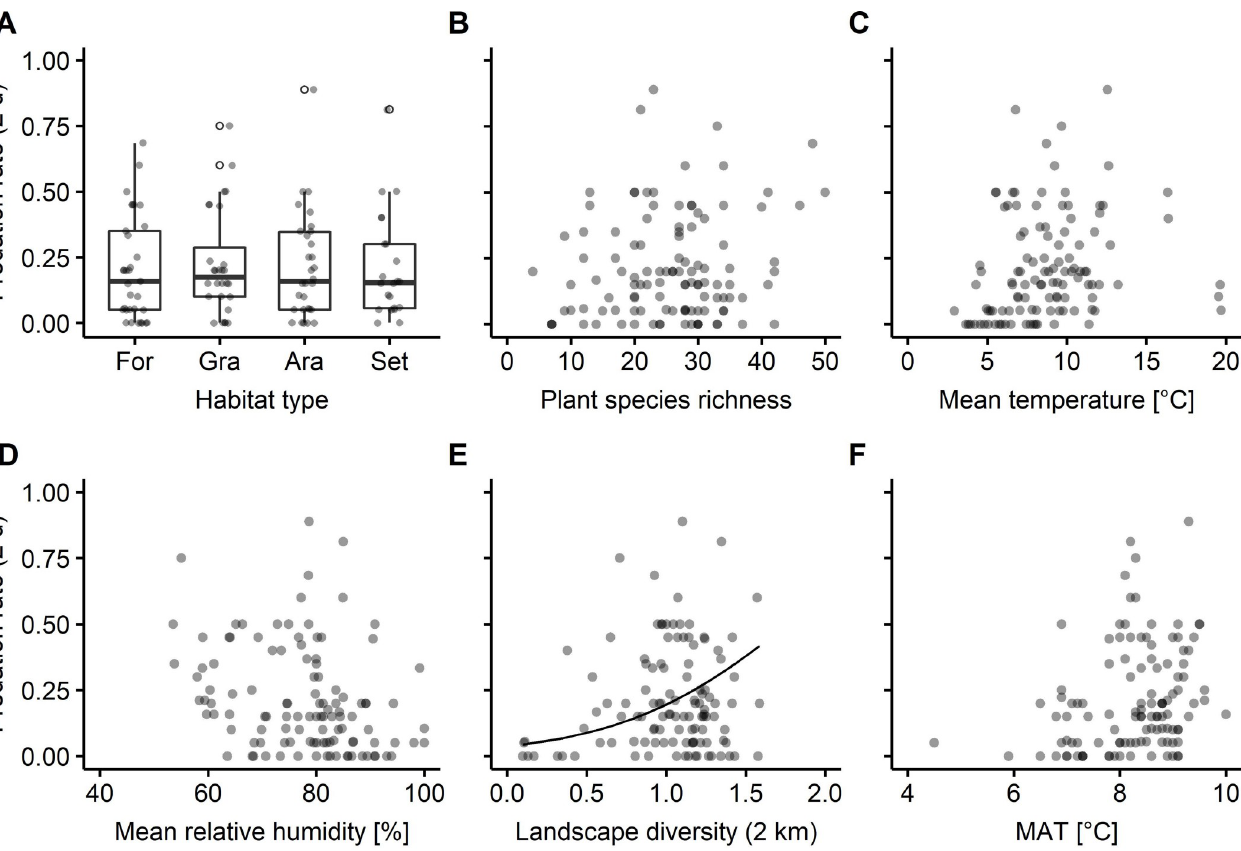
Fig 3. Relationship between arthropod predation rates and candidate predictors. A) Habitat type (For: forest, Gra: grassland, Ara: arable field, Set: Settlement), B) plant species richness, C+D) local mean temperature and mean relative humidity during artificial caterpillar exposure, E) landscape diversity at 2-km scale and F) multi-annual mean temperature (MAT). Light grey dots present values per plot; overlapping dots appear darker. In A) circles indicate outliers. In B-F) solid lines indicate model predictions of the best model derived through multimodel